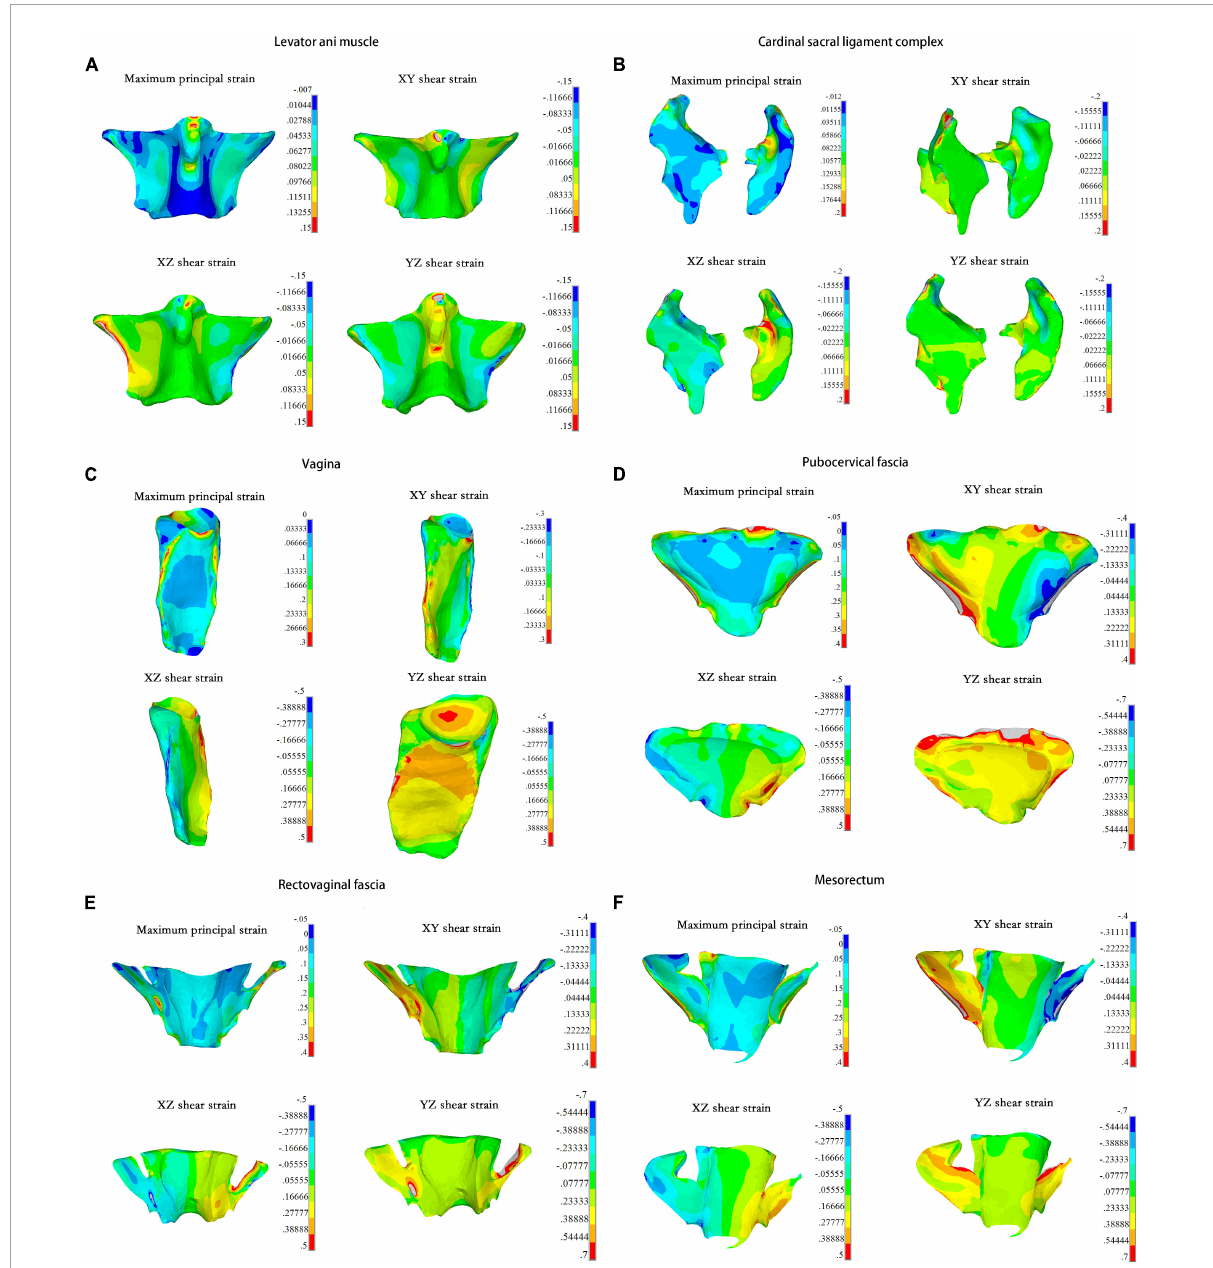
FIGURE3 The maximum principal strain and strains of three directions in each pelvic organs under 0.01 MPa intra-abdominal pressure. For the (A) Levator ani muscle; (B) Cardinal sacral ligament complex; (C) Vagina; (D) Pubocervical fascia; (E) Rectovaginal fascia; (F) Mesorectum.